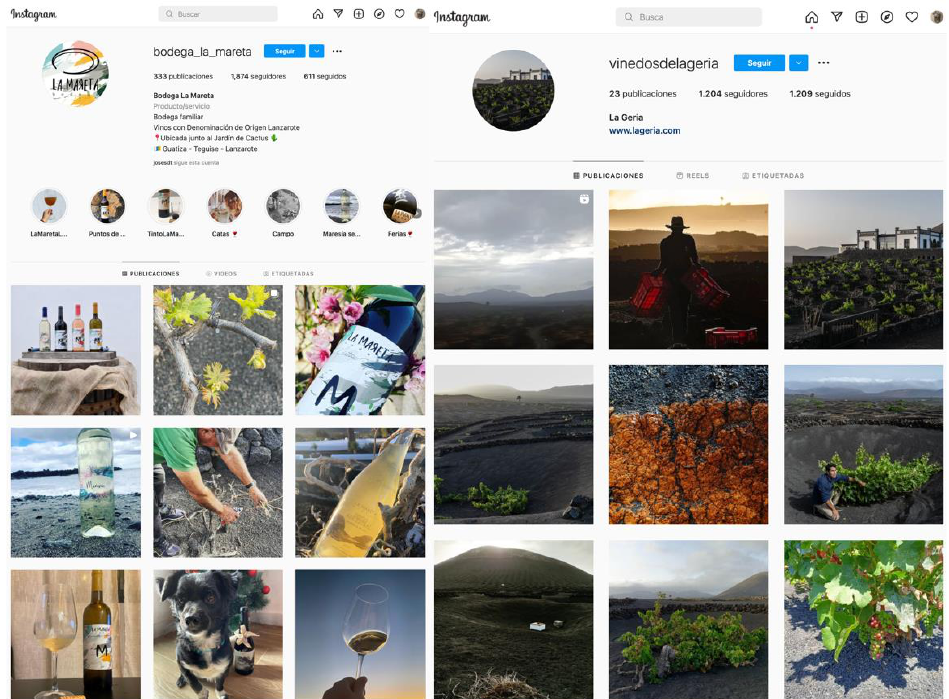
Figure 11. Instagram profiles of the Lanzarote AO. Source: Own elaboration.